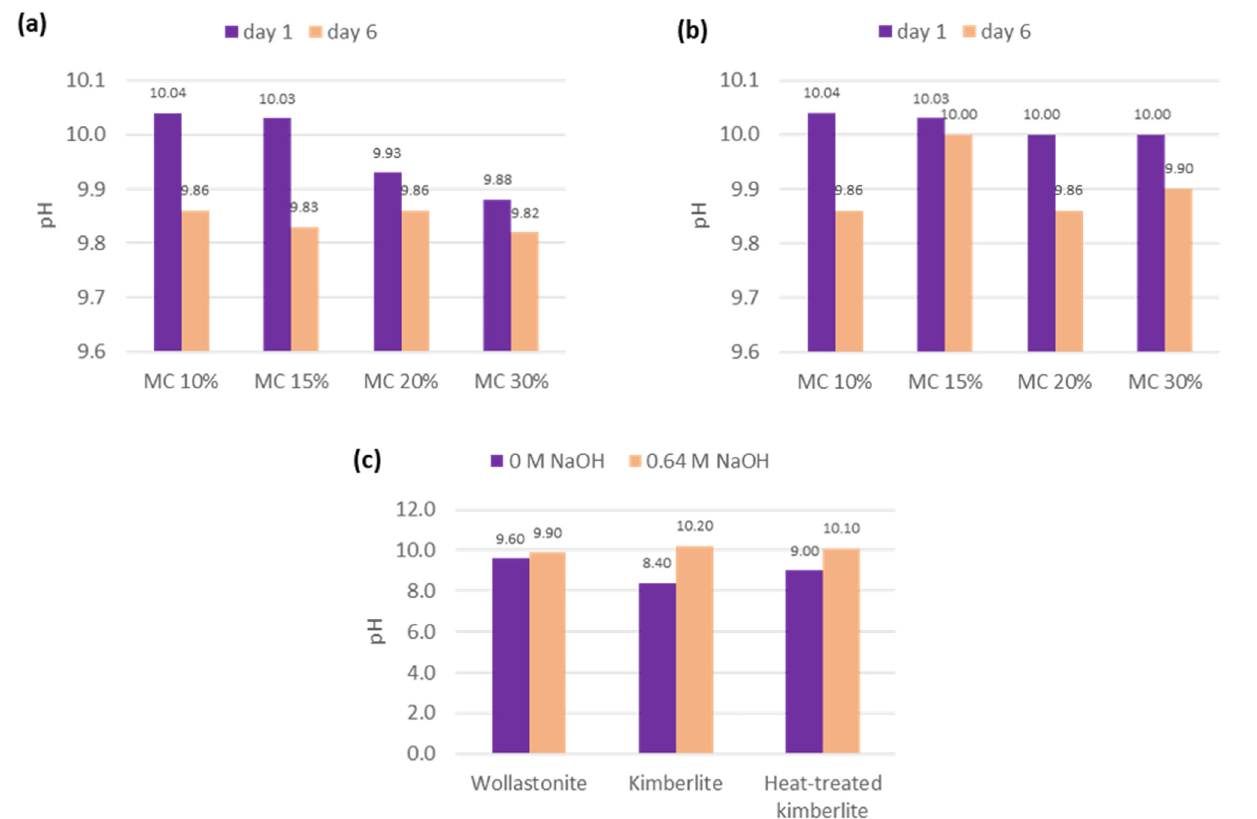
Figure 3. The pH of carbonated wollastonite after incubator carbonation (24 h and 144 h) at 10% CO 2 and reaction temperatures of ( a ) 35 ◦ C and ( b ) 50 ◦ C where MC represents moisture content; ( c ) pH of carbonated wollastonite and kimberlite through pressurized carbonation (4 h, 200 ◦ C, 60 bar CO 2 ). The pH of unreacted kimberlite, heat treated kimberlite, and wollastonite are 9.2, 9.0, and 10.0, respectively.